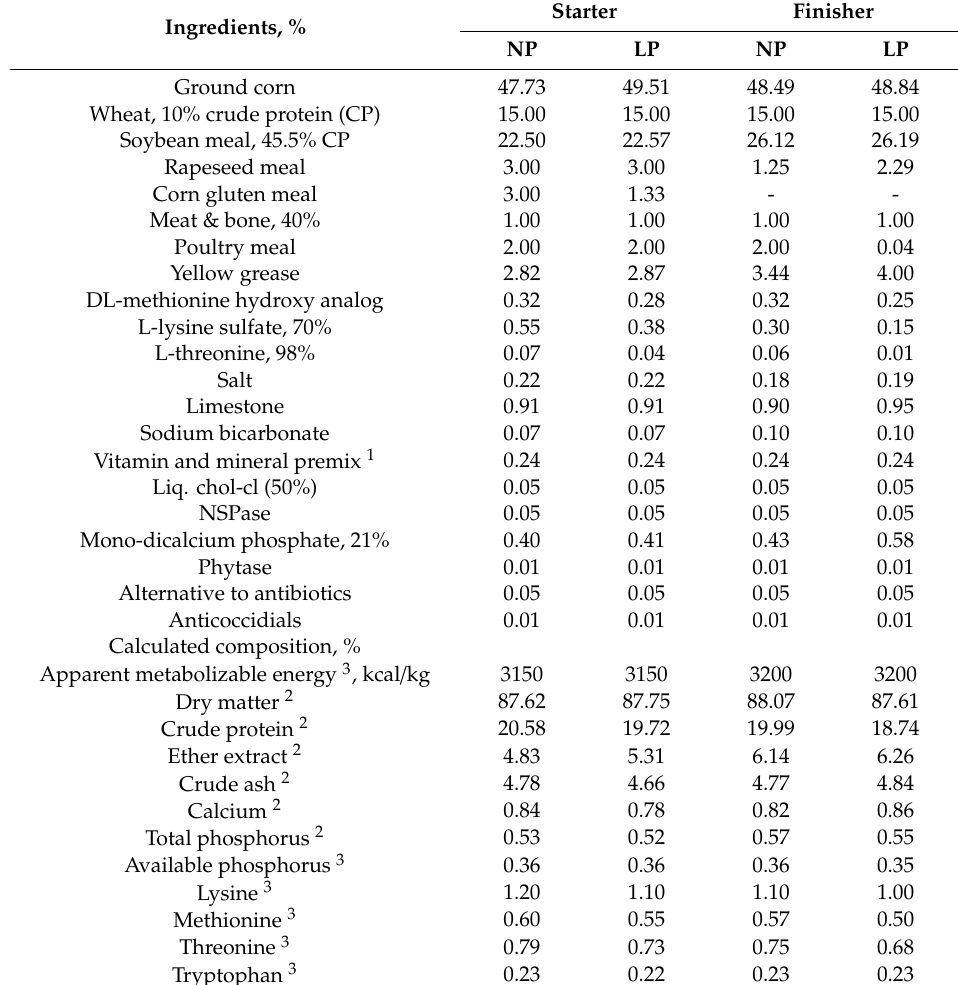
Table 1. Ingredients and nutrient composition of the basal normal- (NP) and low-protein (LP) diets. Ingredients,